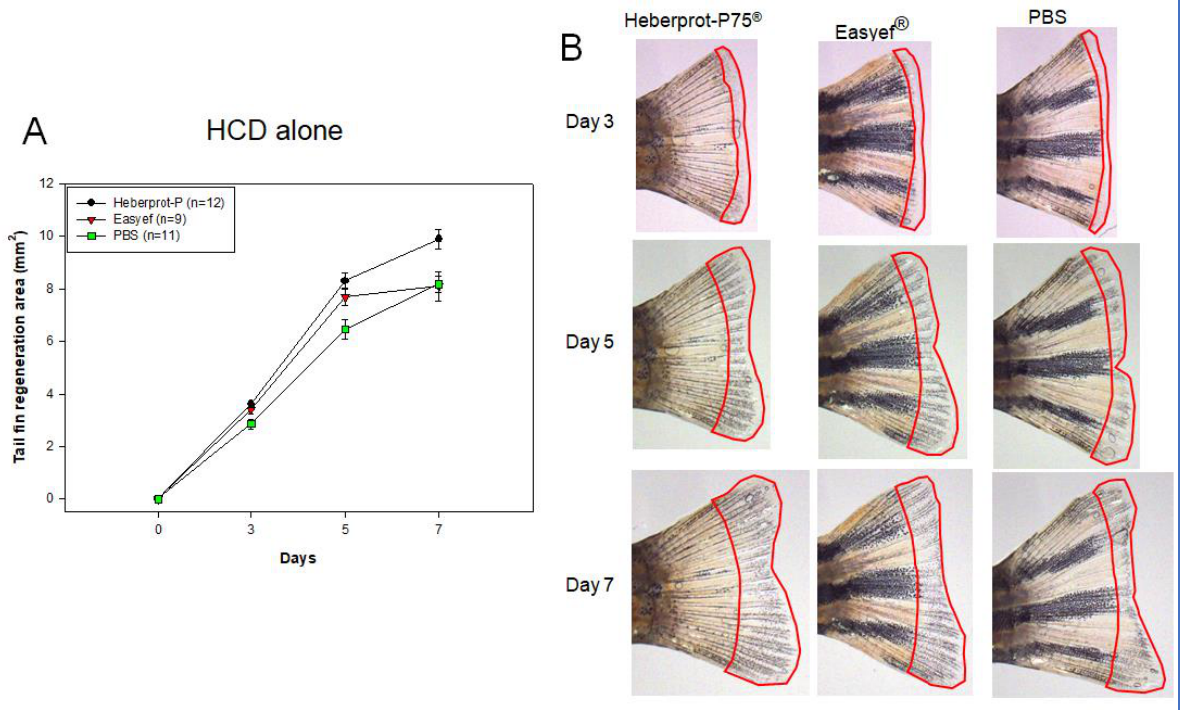
Figure 7. Comparison of tissue regeneration speed ( A ) and morphology in the tail fin area ( B ) under HCD consumption alone over seven days. HCD, high cholesterol diet.